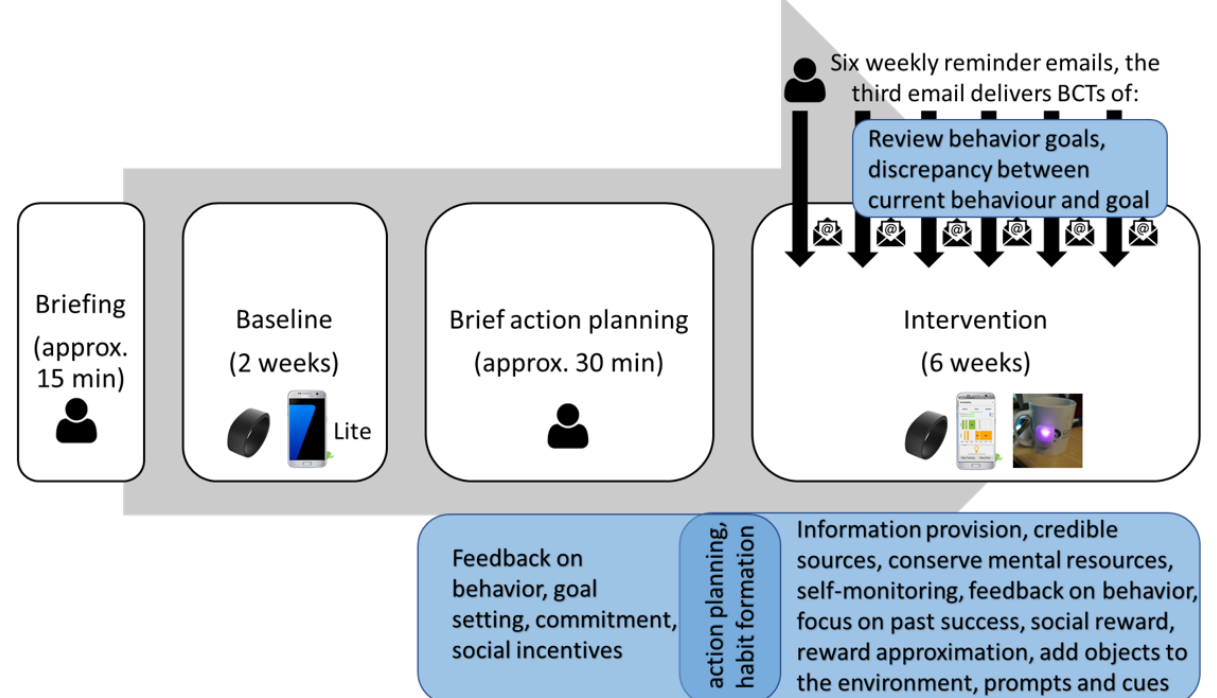
Figure 7. The timing and dosage of delivery for each intervention component and the underlying behavior change techniques (BCTs). The underlying BCTs are specified in blue boxes, and the modes of delivery are indicated by icons (eg, wrist device, smartphone app, cup device, and researcher’s